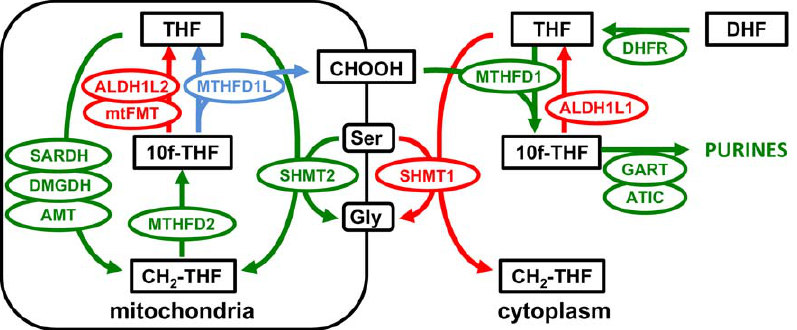
Figure 3. Purine Metabolic Cassette. The subset of reactions within the folate metabolic pathway that have been inferred to be relevant to purine biosynthesis based on observations in the literature (see text for details). Genes (balloons) and their cognate enzymatic steps (arrows) are colored either green (beneficial to purine synthesis) or red (detrimental to purine synthesis). The MTHFD1L reaction, responsible for generating mitochondrial formate [31] and beneficial to purine synthesis, is shown in blue because it was not one of the 31 sequenced genes.